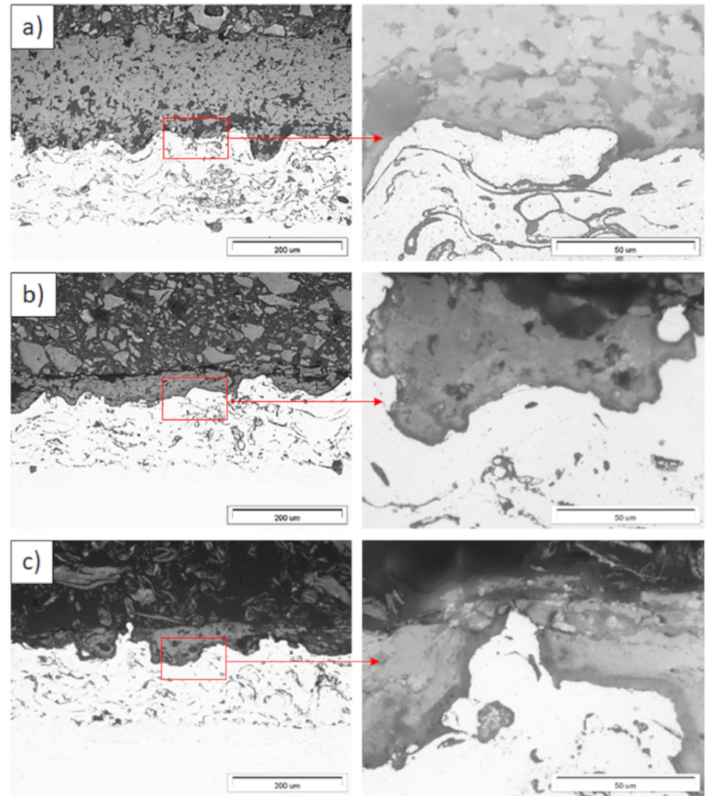
Figure 11. Ceramic layer / bond-coat interfaces of the TBC systems as a function of oxidation time at a temperature of 1100 ◦ C—monolayered La 2 Zr 2 O 7 TBC (light microscopy): ( a ) 2 h, ( b ) 48 h, and ( c ) 175